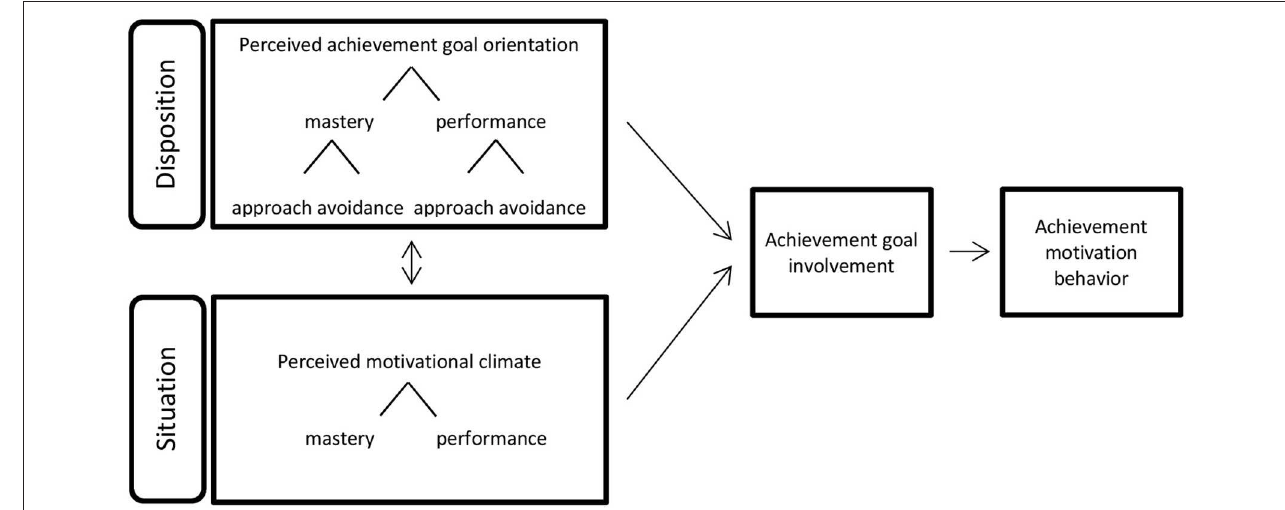
FIGURE 1 | Basic tenets of Achievement Goal